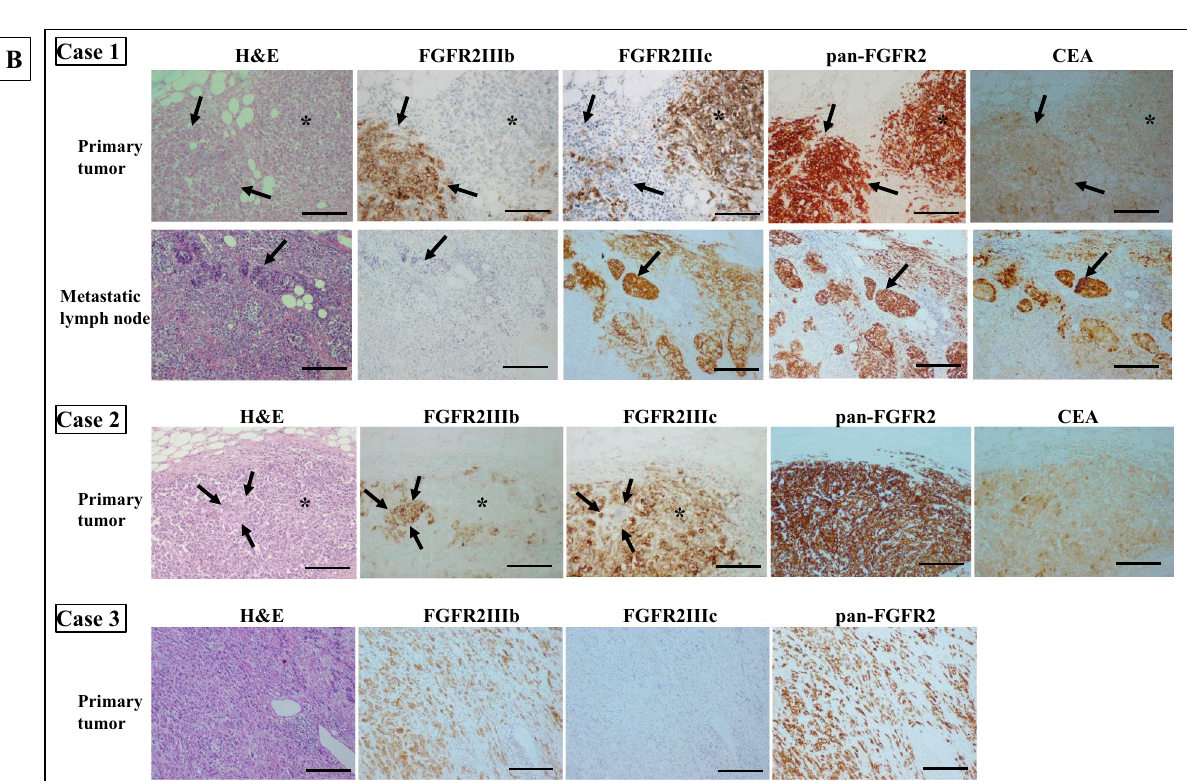
Figure 1. Representative pictures of FGFR2IIIb and FGFR2IIIc expression in gastric cancer. ( A ) IHC score of FGFR2IIIb and FGFR2IIIC. FGFR2IIIb and FGFR2IIIc were mainly expressed at cell membrane (arrows and inset). The immunoreactivity of FGFR2IIIb and FGFR2IIIc were evaluated according to the intensity of membranous staining score 0–3, as follows: 0, negative; 1 +, weak at cytosol; 2 +, moderate at cell membrane; 3 +, strong at cell membrane. FGFR2IIIb and FGFR2IIIc expression were considered positive when scores were ≥ 2. Bar = 100 μm. ( B) Representative cases stained with H&E, FGFR2IIIb, FGFR2IIIc, pan-FGFR2, and CEA of gastric cancer. Heterogeneous expressions of FGFR2IIIb isoform and FGFR2IIIc isoform were found in a tumor (Case 1 and Case 2). The pan-FGFR2 detected both FGFR2IIIb isoforms and FGFR2IIIc isoforms. FGFR2IIIb expression (arrows) and FGFR2IIIc expression (asterisks) were positive in the same tumor, but both were not positive in the same tumor cells. FGFR2IIIc dominant expression in a metastatic lymph node disease was found in Case 1. CEA determined cancer cells in the primary tumor and the lymph node. In contrast, Case 3 shows FGFR2IIIb expression, but not FGFR2IIIc expression. × 100. Bar = 200